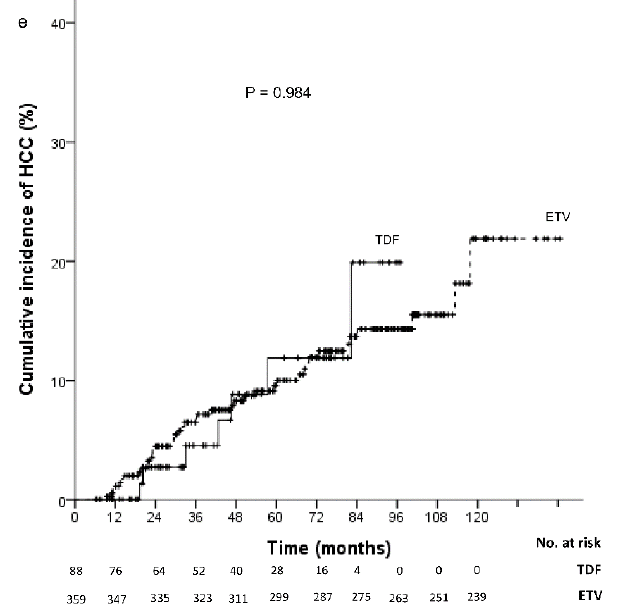
Figure 1. Cumulative incidence of hepatocellular carcinoma assessed using baseline risk factors: ( a ) age; ( b ) albumin; ( c ) HBV DNA; ( d ) AFP; ( e ) NUCs. Patients with older age, higher AFP and HBV DNA levels, and low albumin levels had a higher risk for HCC development during NUC therapy. The risk of HCC development was not different between the two NUCs. AFP, α -fetoprotein; NUC, nucleos(t)ide analogue; TDF, tenofovir; ETV, entecavir.